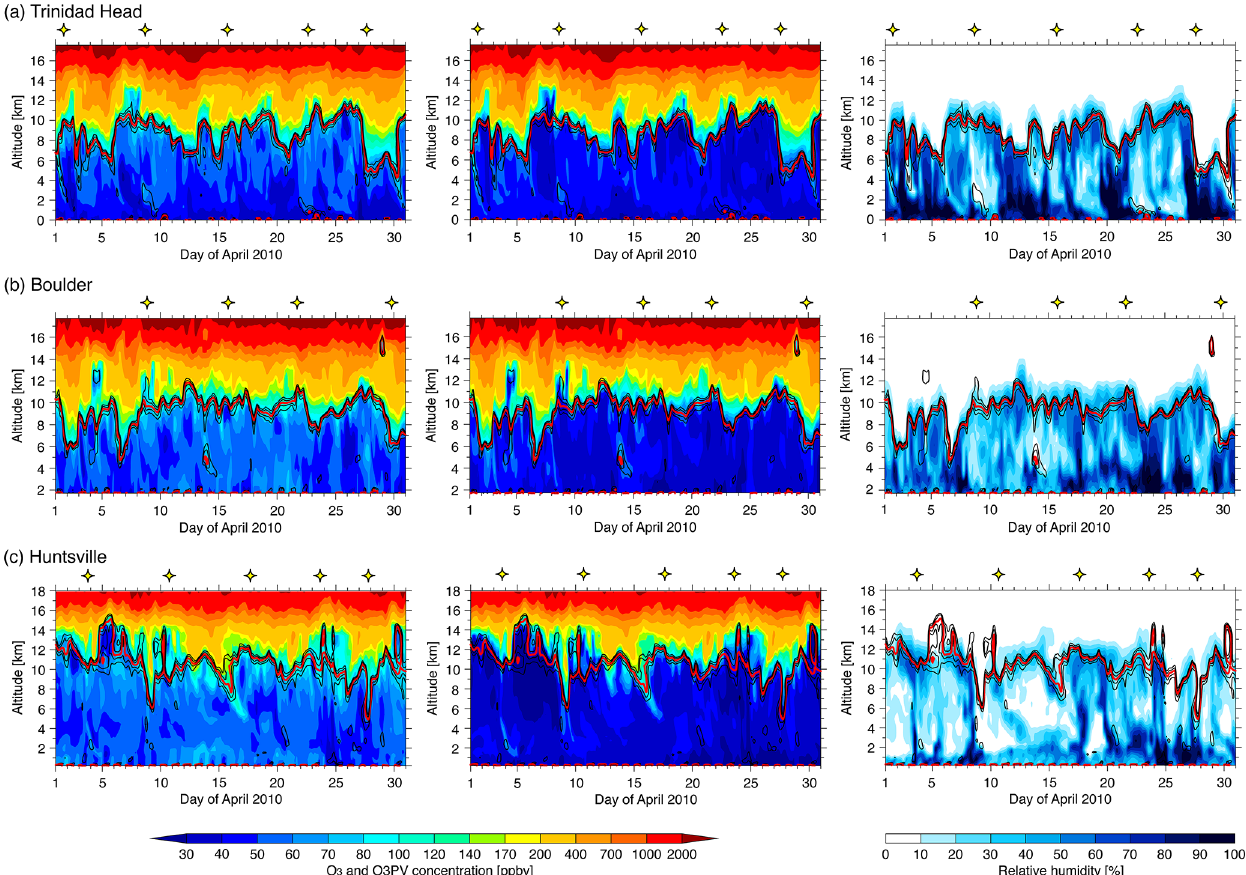
Figure 4. Curtain plots of modeled (left) O 3 , (center) O3PV, and (right) RH at US ozonesonde sites of (a) Trinidad Head (CA), (b) Boulder (CO), and (c) Huntsville (AL) during April 2010. Yellow stars indicate the time of available ozonesonde measurements. Contour lines of modeled PV are also inserted for contours of 1.0, 1.5, 2.0, 2.5, and 3.0 PVU, with thick red lines denoting the 2.0 PVU contour as an index to diagnose the